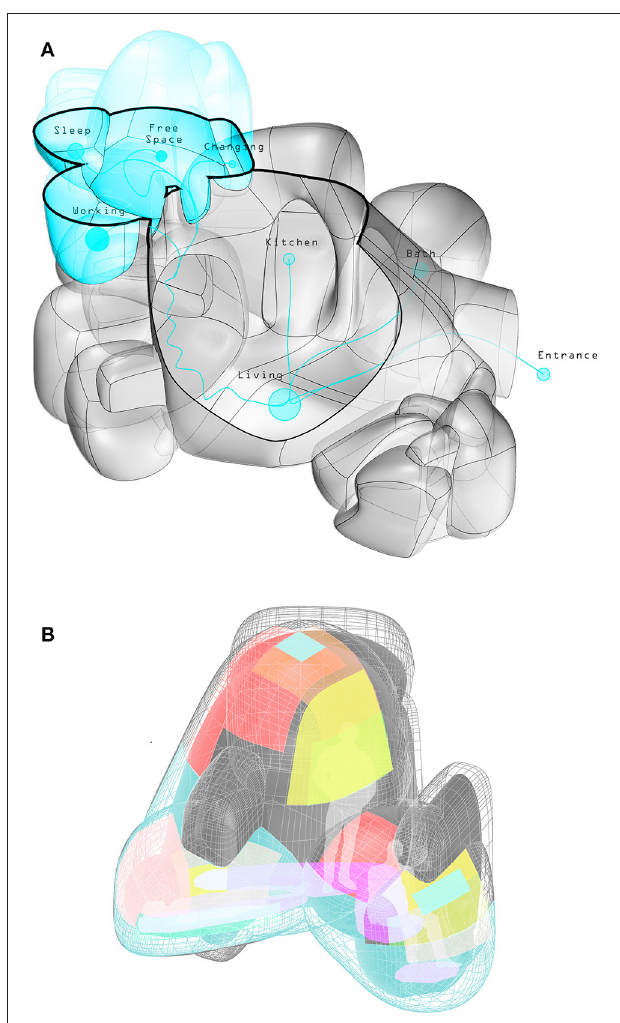
FIGURE 2 | Overall geometry obtained from movement mapping (A) with climate requirements mapped on a fragment (B)